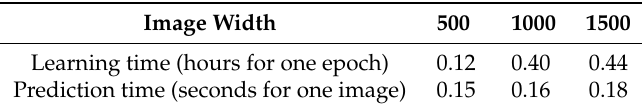
Table 7. Computation times for a GTX 1060 GPU (6go